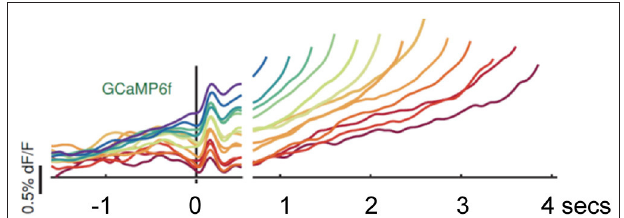
FIGURE 2 | Hamilos et al. (14), with permission (Creative Commons Attribution License permits unrestricted use and redistribution provided that the original author and source are credited). Abbreviations are those used in the text. Average DAN GCaMP6f responses from 12 mice. The different colored